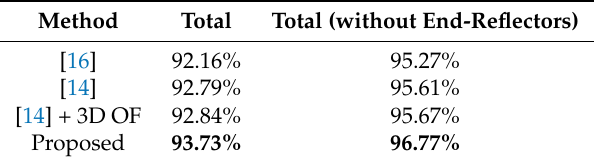
Table 3. mAP for PCK with α = 0.05, with and without